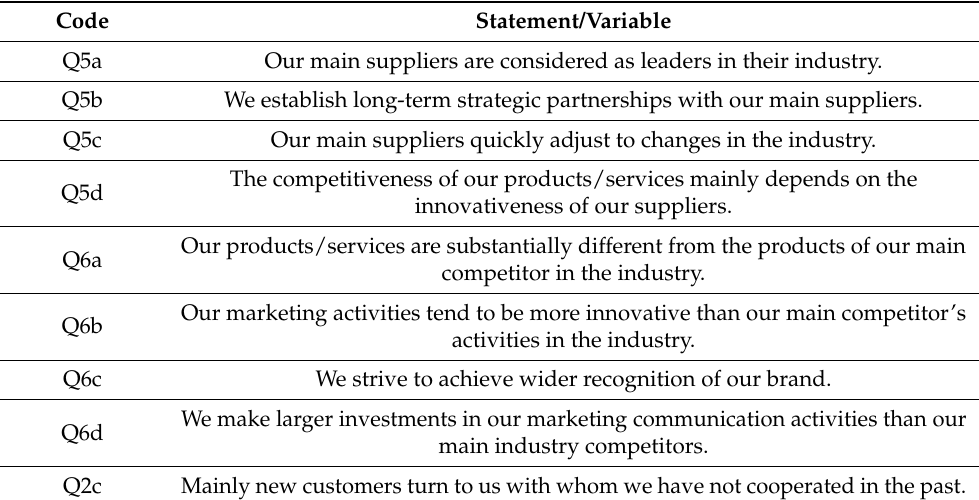
Table 1. Variable codes in the SEM